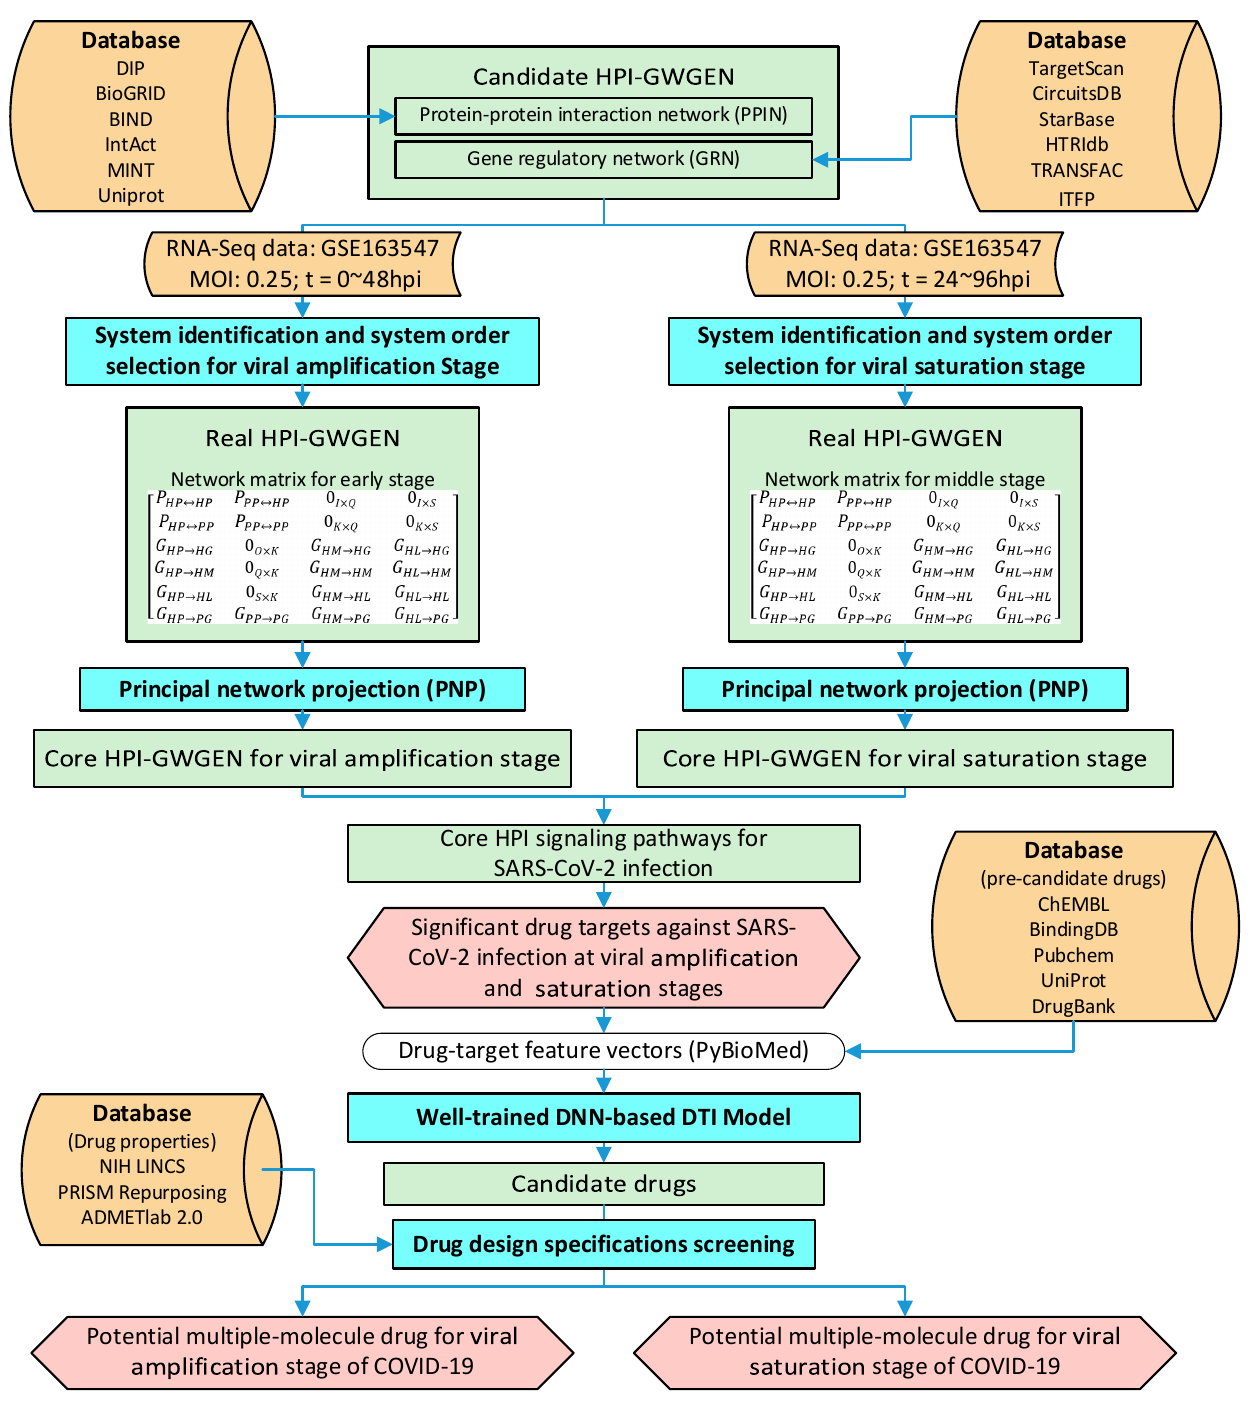
Figure 1. The flowchart of the systems biology method of investigating pathogenesis of SARS-CoV-2 infection to identify significant biomarkers as drug targets and systems drug discovery via a DNN- based DTI model to predict candidate molecular drugs for drug targets through a deep learning scheme and then to screen multiple-molecule drugs by drug design specifications for disrupting the SARS-CoV-2 infection at the amplification and saturation stages. The number of nodes and edges in candidate HPI-GWGEN and real HPI-GWGENs of amplification and saturation infectious stages are shown in Table 1. The significant pruning of edges between candidate and real HPI-GWGEN implies that the false-positive edges in candidate HPI-GWGEN are eliminated by the system order selection. The real